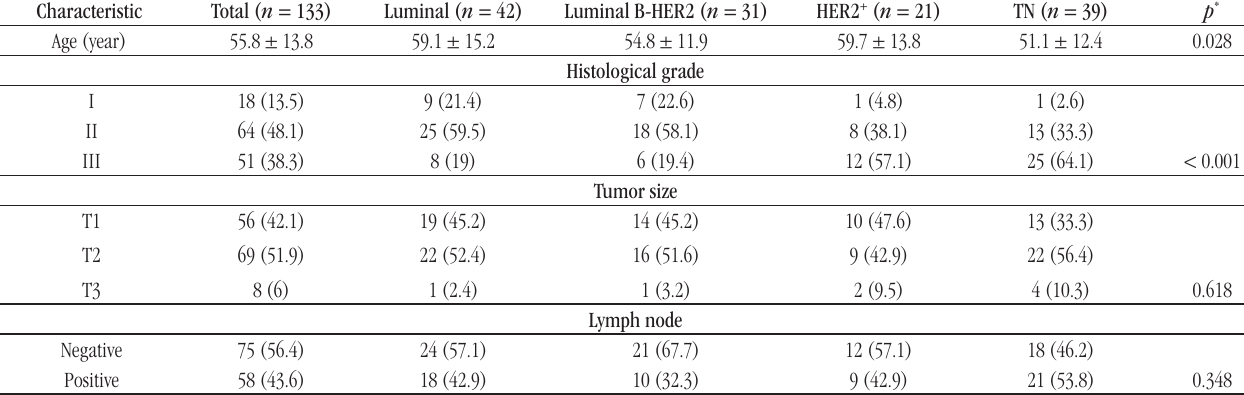
taBLE 4 − Clinicopathological characteristics of patients and comparison with molecular subtypes Characteristic Total ( n =